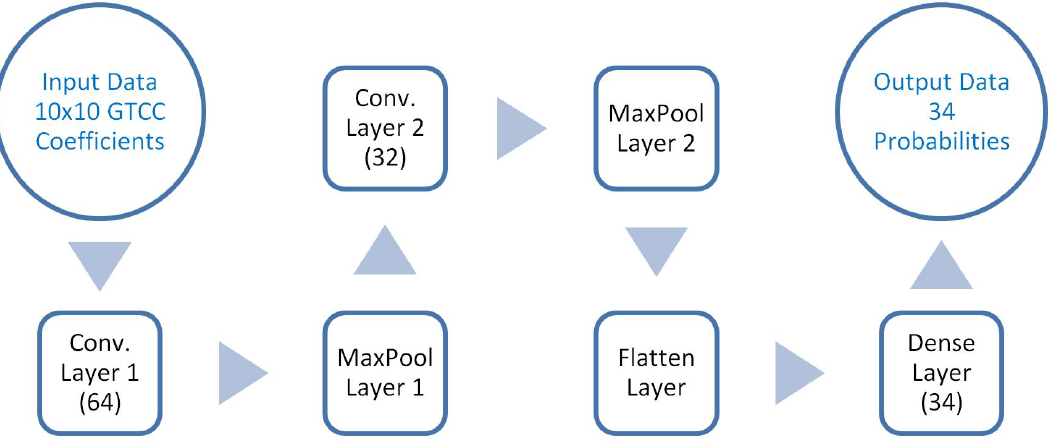
Figure 1. Model of the implemented